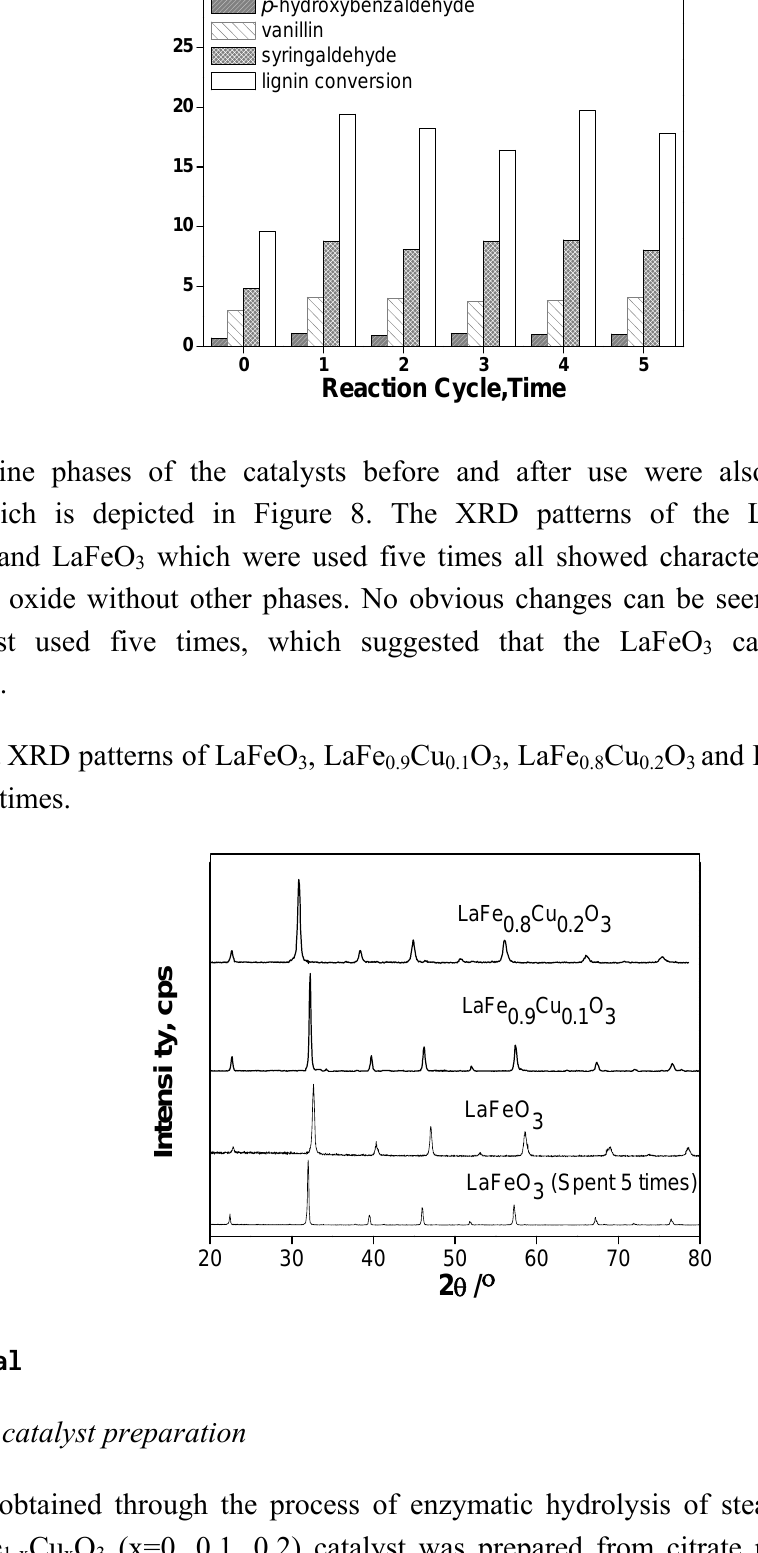
for 30 minutes (other reaction conditions as 3